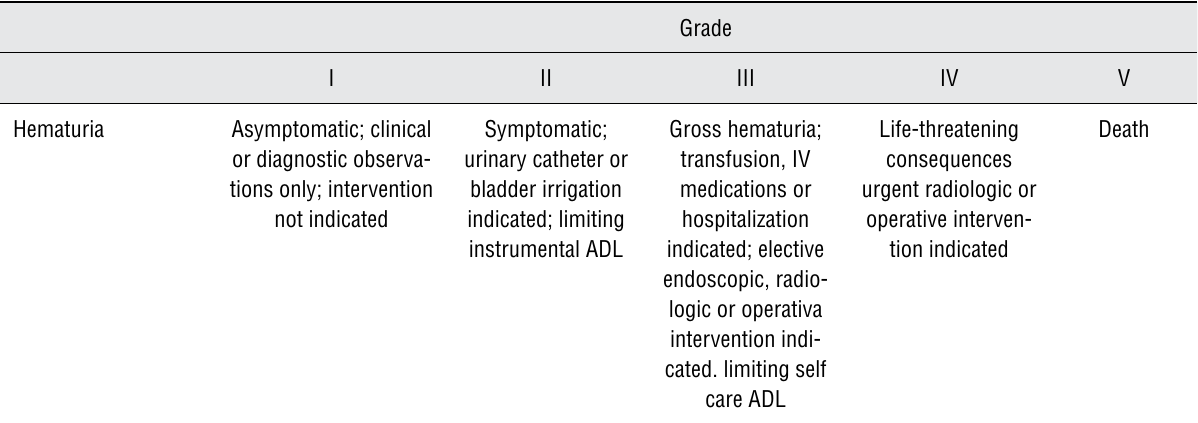
Table 4 - CTCAE – Common Terminology Criteria for Adverse Events grading for